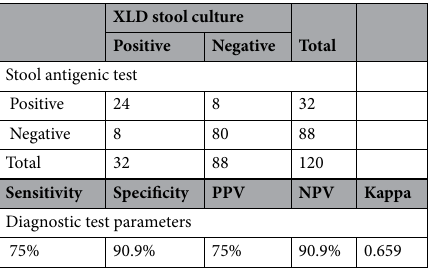
Table 1. Pilot depicting sensitivity, specificity, and predictive values of stool antigenic test against XLD stool culture, Northeast, Ethiopia, 2021.